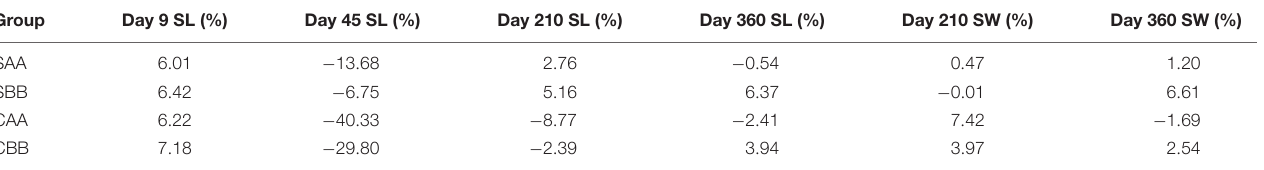
TABLE 5 | Inbreeding depression of growth for within-family crosses of P. martensii (SL: shell length; SW: shell width). Group